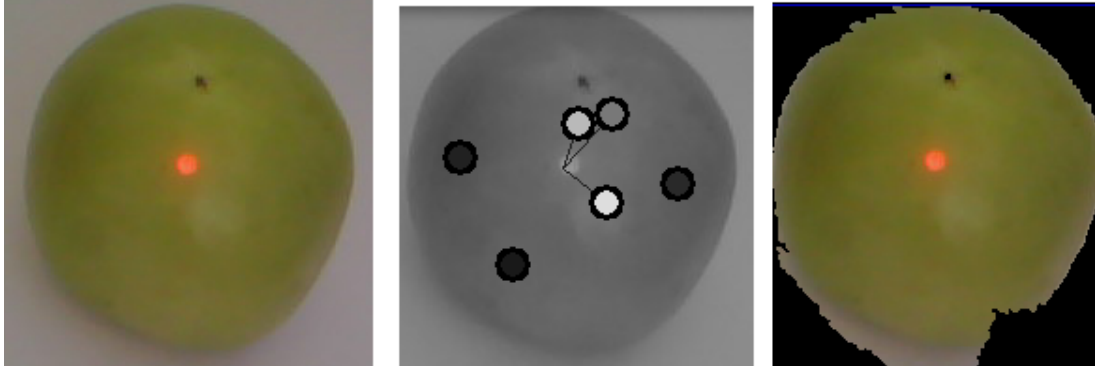
Figure 19. A green tomato image (left), with several laser seeds (middle) and resulting segmentation